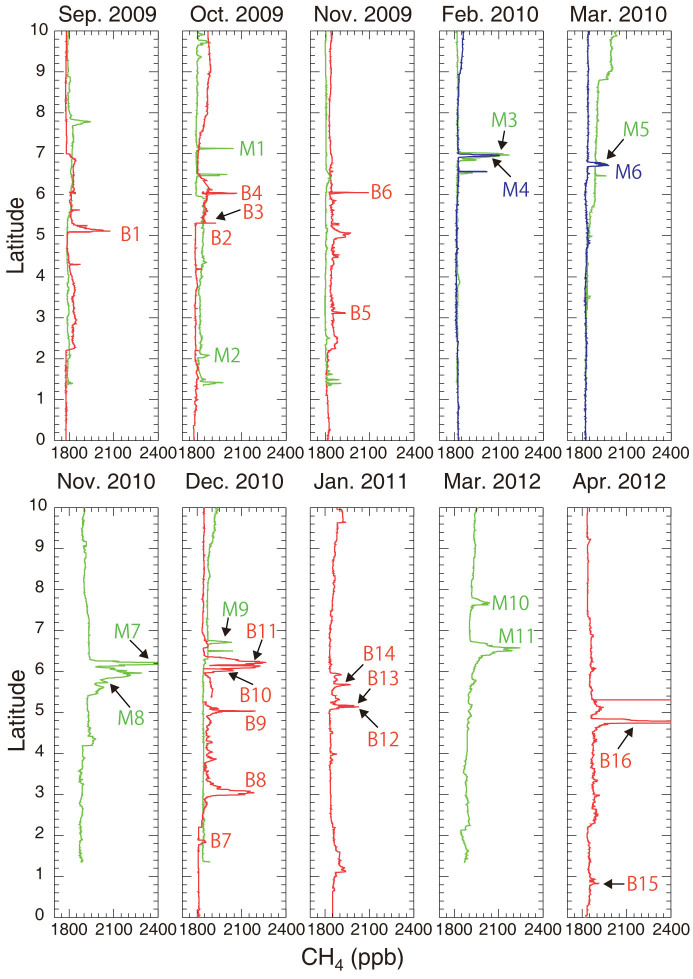
Latitudinal distribution of 1-min temporally averaged CH4 mole fractions between latitude 10°N and the equator observed during eight voyages along the Southeast Asian shipping routes between September 2009 and April 2012.Mole fractions of CH4 are color coded according to the shipping routes: green for the southbound Asia route, blue for northbound Asia route, and red for northbound Borneo route. Peak numbers are allocated for only the Malay and Borneo peaks (preceded by M or B) that showed substantial CH4 increase (>50 ppb) and positive correlation between CH4 and CO2 (R > 0.4, p-value < 0.05) and that had peak durations of more than 10 min.